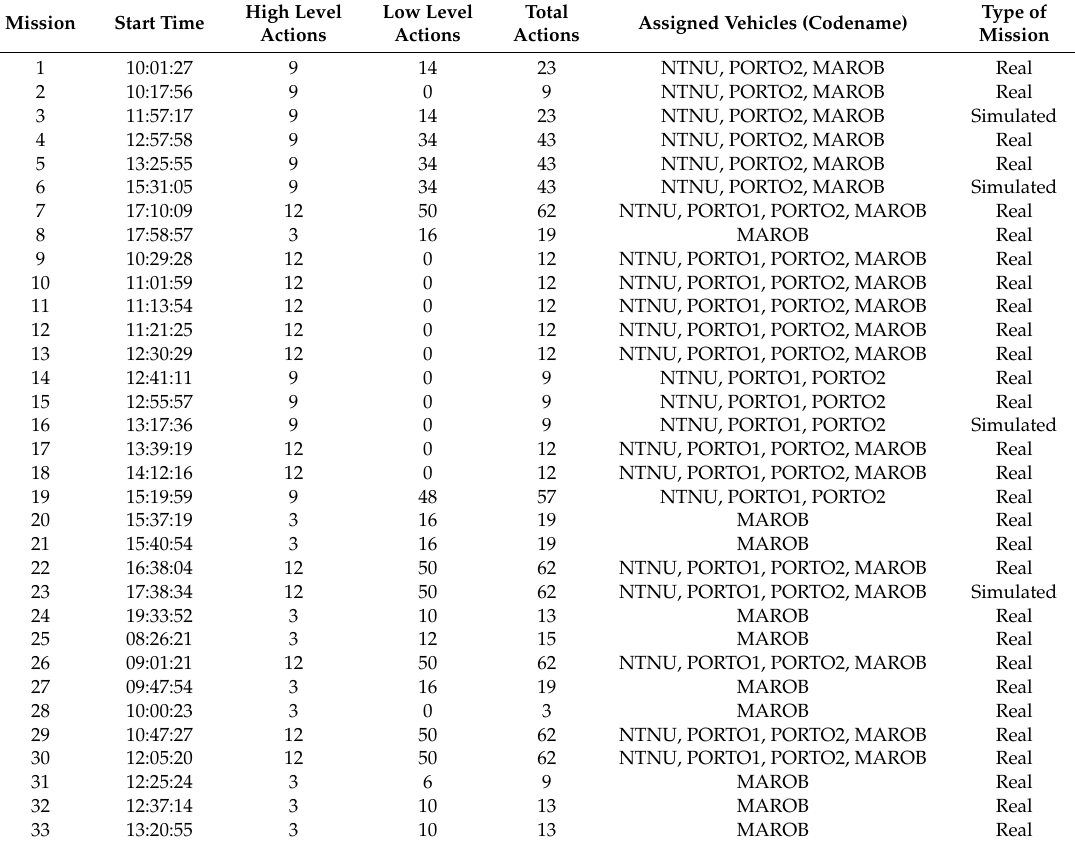
Table 3. Details for each registered